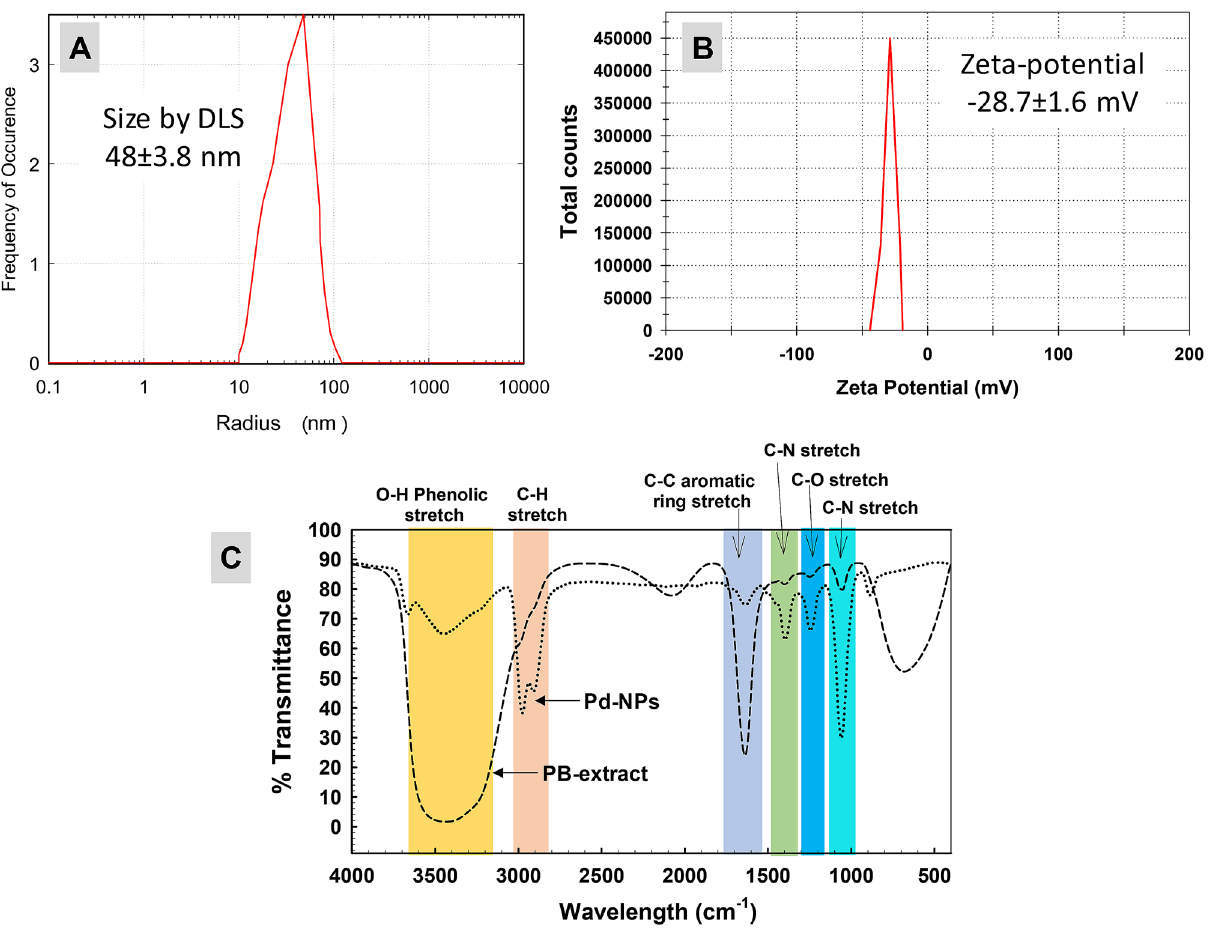
Figure 5. Hydrodynamic size of PB extract-capped Pd-NPs recorded by DLS (panel A) and zeta-potential (panel B). Panel C shows comparative analysis of FT-IR spectra of PB extract and Pd-NPs.